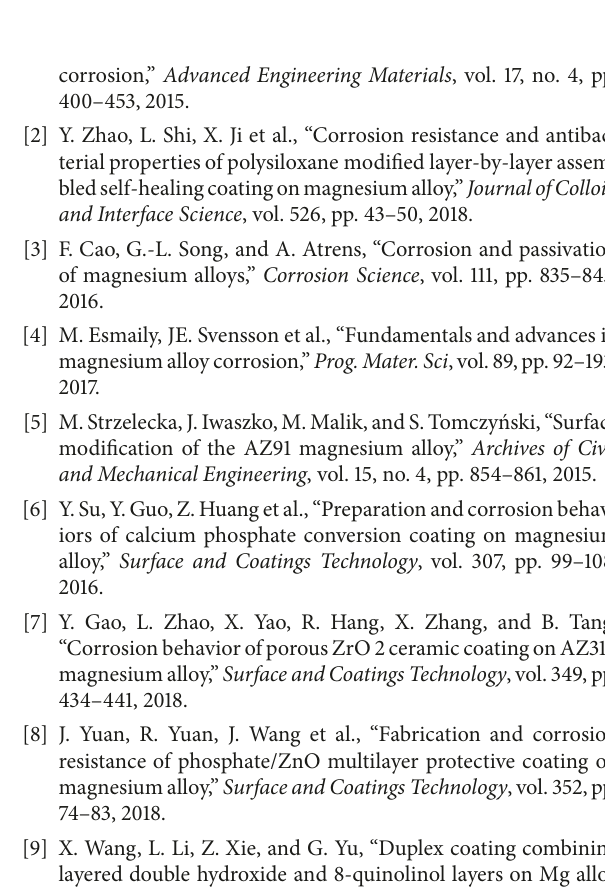
Figure 10: The film-forming process of the LDH conversion coating on the AZ91D magnesium alloy matrix material: (a) morphologies of the 10min sample, (b) morphologies of the 20min sample, (c) morphologies of the 30min sample, and (d) cross-sectional of conversion coating-forming